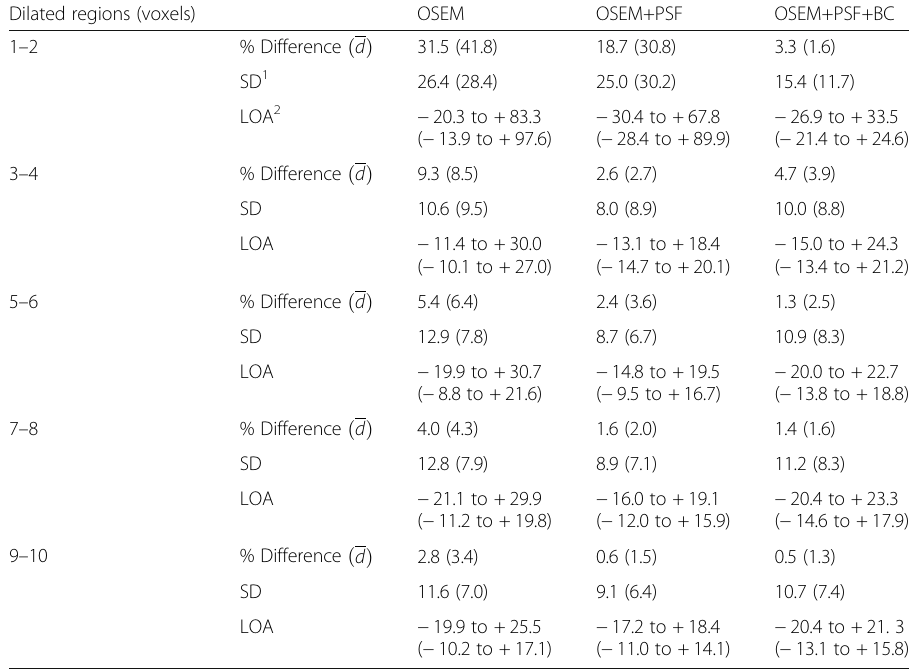
Table 2 Estimation of the spill-in activity from the bladder to the surrounding regions. This is estimated from both filtered and unfiltered mean images with simulated bladder SUV 55.5 at 30 iterations (the filtered results are given in parentheses). ð d Þ is the difference between the mean values of the true simulated and reconstructed images for all voxels in the dilated region. LOA is the 95% Limit of Agreement of ð d Þ , with ± showing the upper and lower limits Dilated regions (voxels) OSEM